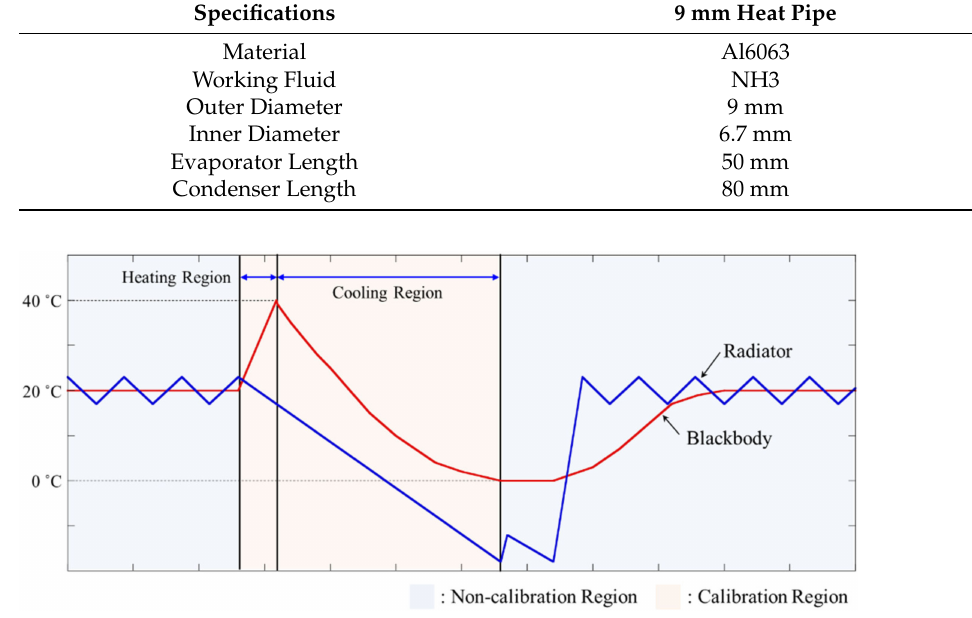
Figure 3. Operating concept of on-board